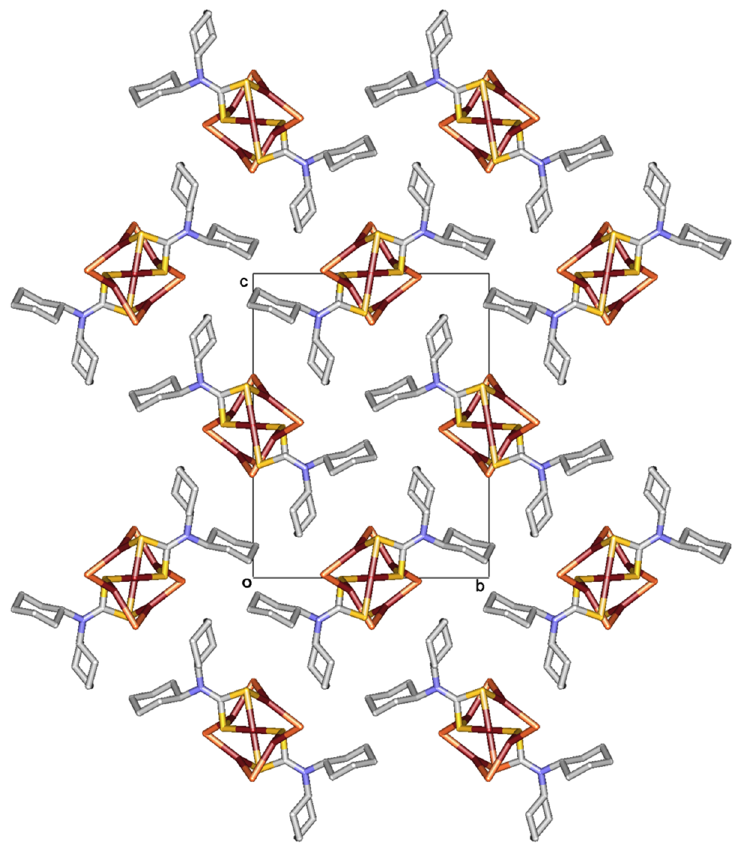
Figure 2. Packing diagram of the mixed-valence Cu(I)–Cu(II) coordination polymer viewed along the a -axis. Hydrogen atoms are